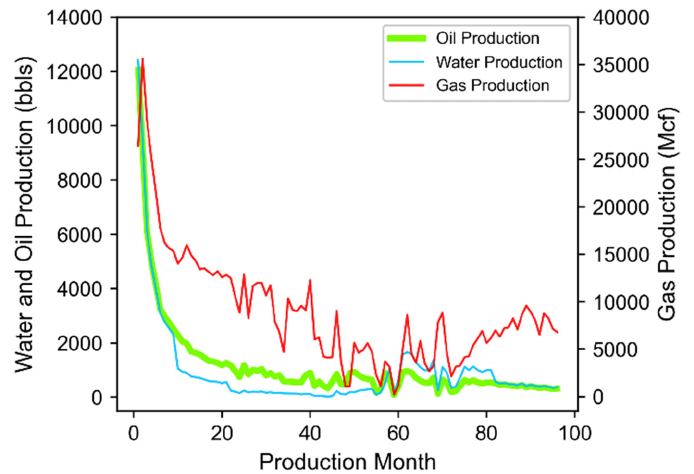
Figure 1. Example of oil, water, and natural gas production data for a horizontal well in northern Reagan County, Texas producing from Wolfcamp A and placed at a total vertical depth of 7713 feet below ground surface. Timeseries fluid data was acquired from vendor Drilling/Enverus [48].